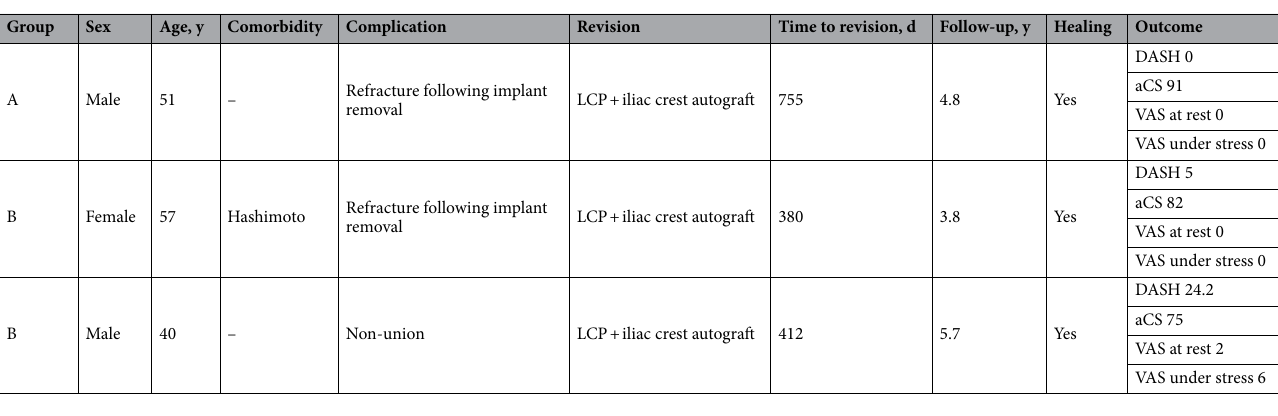
Table 5. Demographic data of the patients with compromised bony healing. aCS: adjusted Constant score, DASH: Disability of the Arm, Shoulder and Hand, IQR: Interquartile range, LCP: locking compression plate, VAS: Visual Analog Scale.